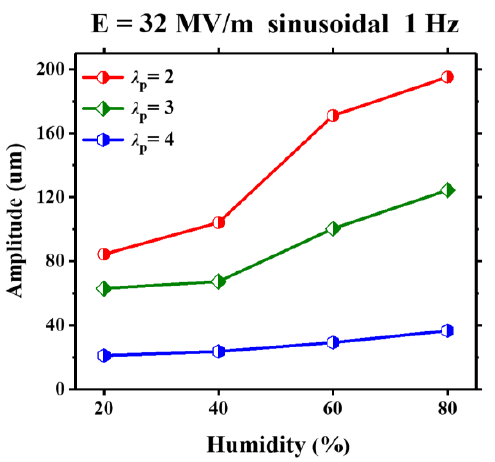
Figure 4. Subject to a sinusoidal voltage, amplitude of the VHB 4905 film under different pre- stretch ratios and ambient humidities.